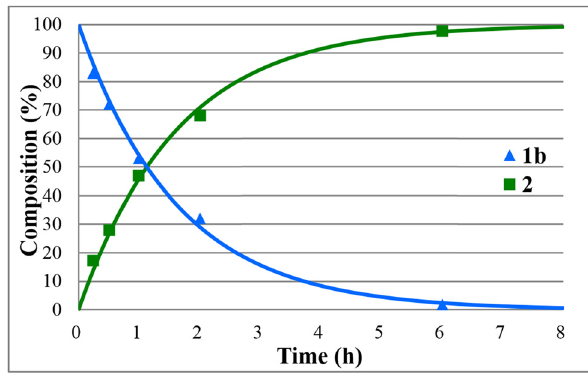
Figure 2: Concentration pro fi le for the components ( 1b and 2 ) during the hydrolysis of ethyl diphenylphosphinate ( 1b ) under optimum conditions. The R 2 measure of goodness of fi t is 0.995.